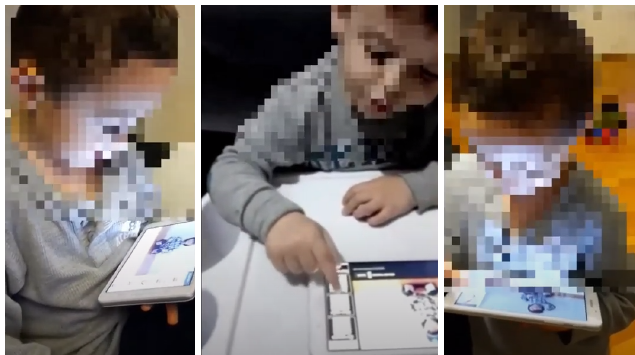
Figure 3. Children while using the application.